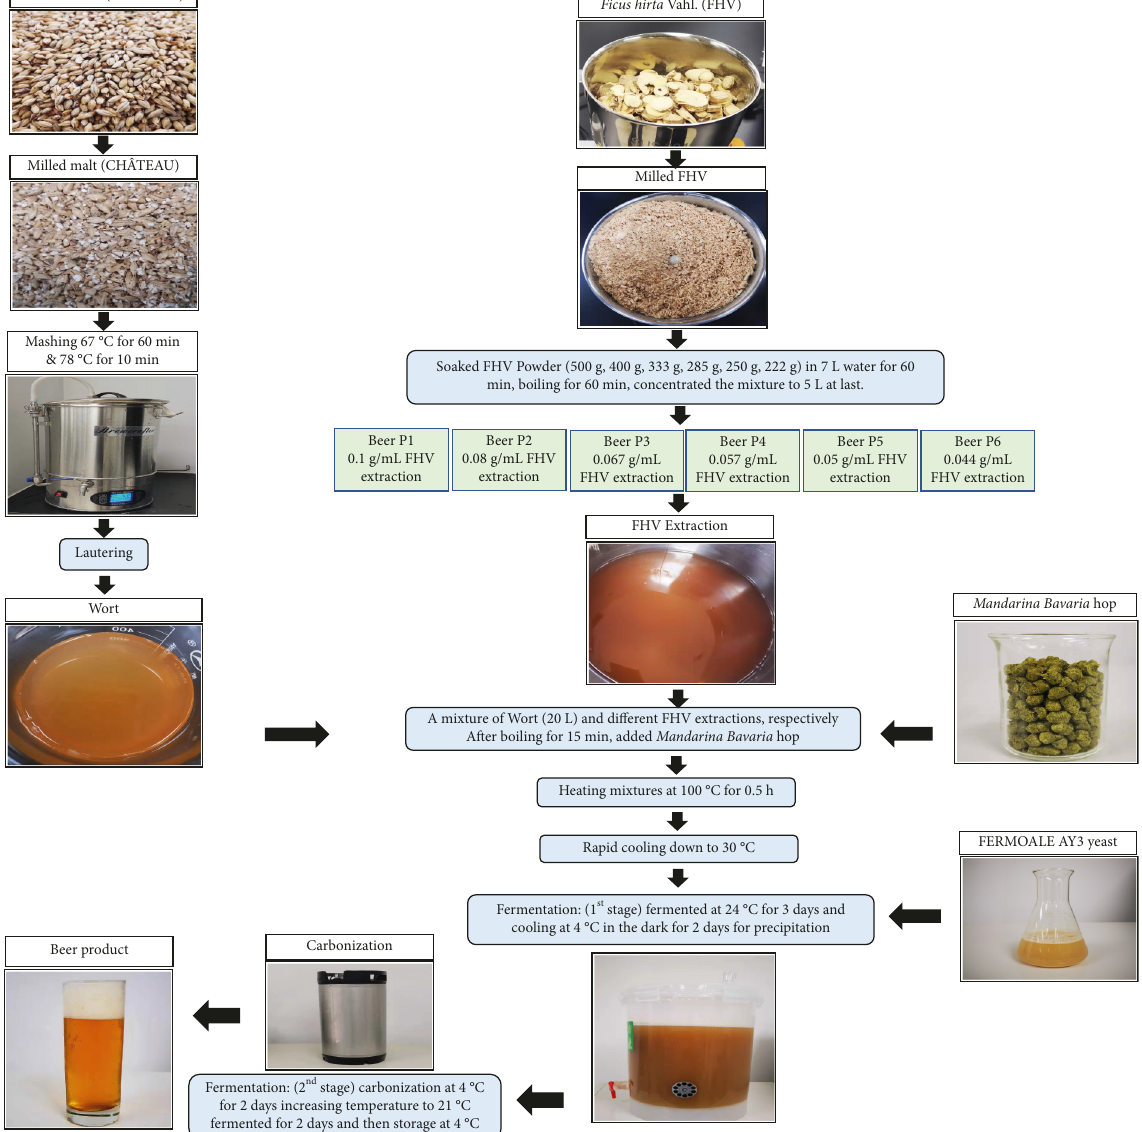
Figure 1: Flowchart of Ficus hirta Vahl. (FHV) beer production